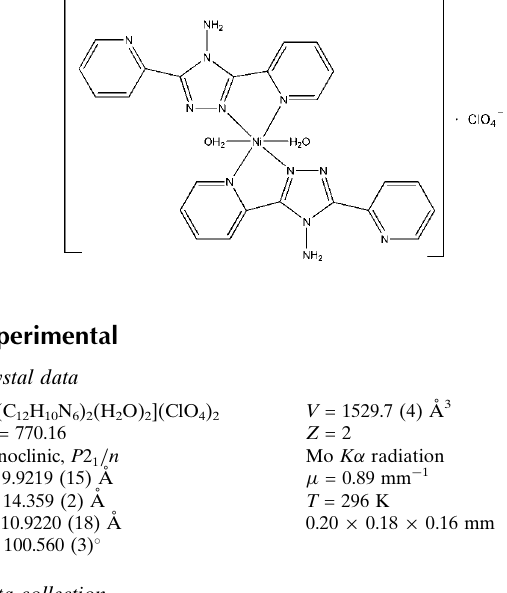
Data collection Bruker SMART CCD area-detector diffractometer Absorption correction: multi-scan ( SADABS ; Bruker, 2001)